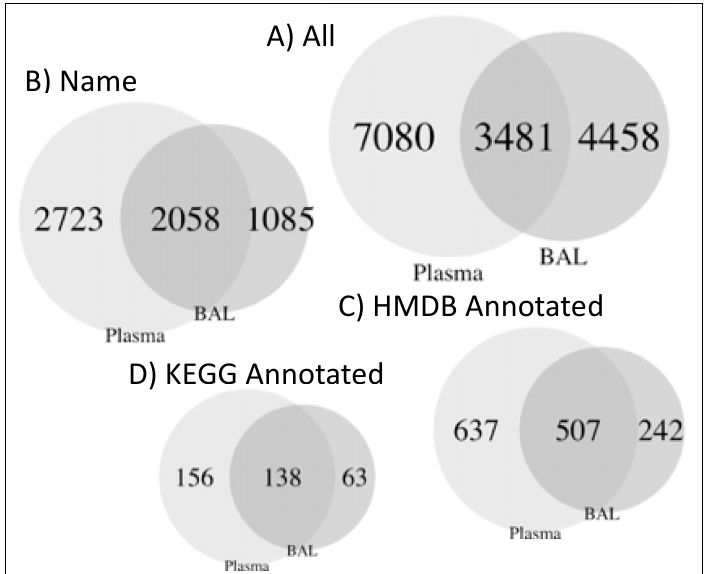
Figure 1. Compilation of Venn diagrams for bronchoalveolar lavage (BAL) and plasma compounds. All compounds ( A ), only annotated compounds ( B ), or annotated compounds with identifiers in HMDB ( C ), or KEGG ( D ) databases.